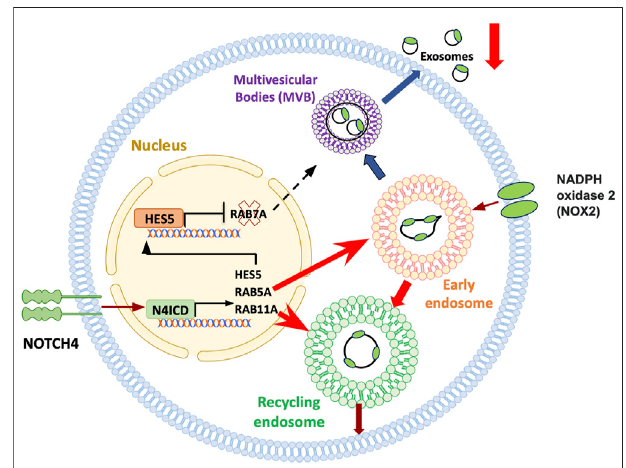
FIGURE 6 | Treg cell failure in aging. Subtle and frank in fl ammatory states of the aging host have been attributed to a failure of immunosuppressive T regulatory (Treg) cells. Treg cells rely on an array of mechanisms targeting and suppressing effector T cells. CD8 + Treg cells function by releasing immunosuppressive exosomes that contain NOX2. Numbers and functional competence of such CD8 Treg cells decline with progressive age in healthy individuals, a process aggravated in the age- associated autoimmune disease giant cell arteritis. In aging CD8 + Treg cells, aberrant expression of NOTCH4 redirects the traf fi cking of intracellular vesicles, essentially disrupting the release of immunosuppressive exosomes. Notch4 signaling targets multiple genes that guard the intracellular vesicle machinery, including RAB5, RAB7 and RAB11. Consequently, early lysosomes are directed towards the recycling pathway, trapping NOX2 in the cell, while formation of multivesicular bodies (MVB) and exosome release are